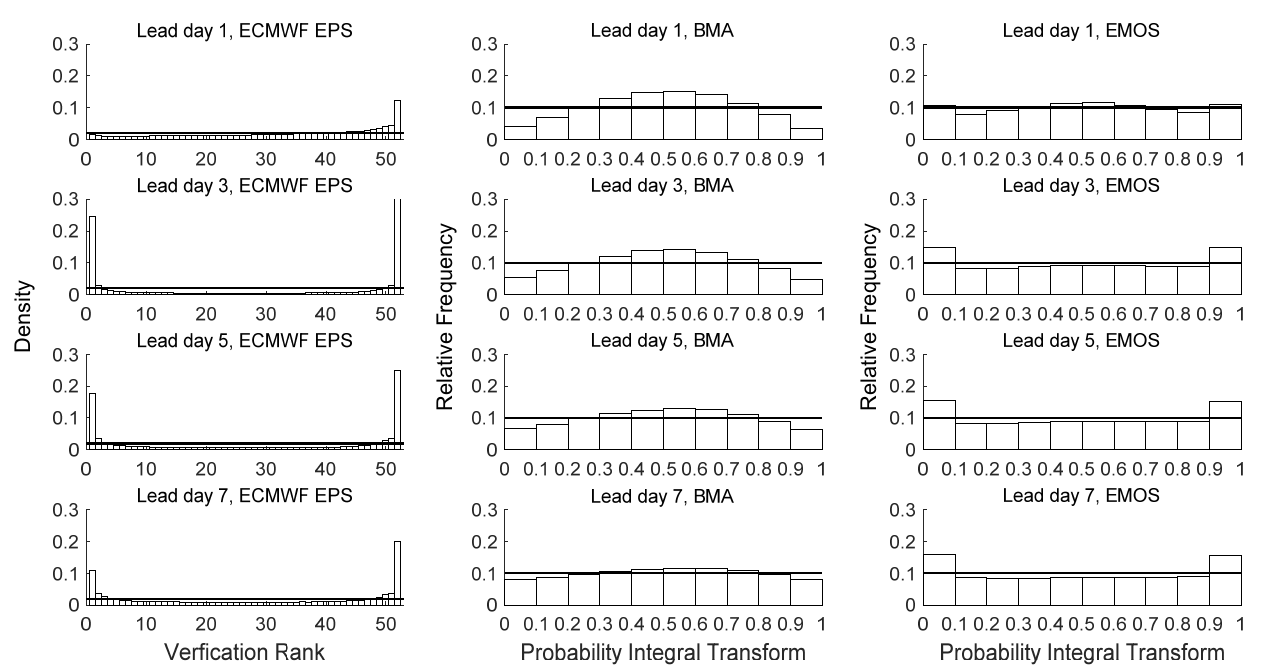
Figure 4. Verification rank histograms for the ECMWF EPS forecasts and the PIT histograms for the BMA and EMOS forecast distributions of the 500 hPa geopotential height with different lead times.